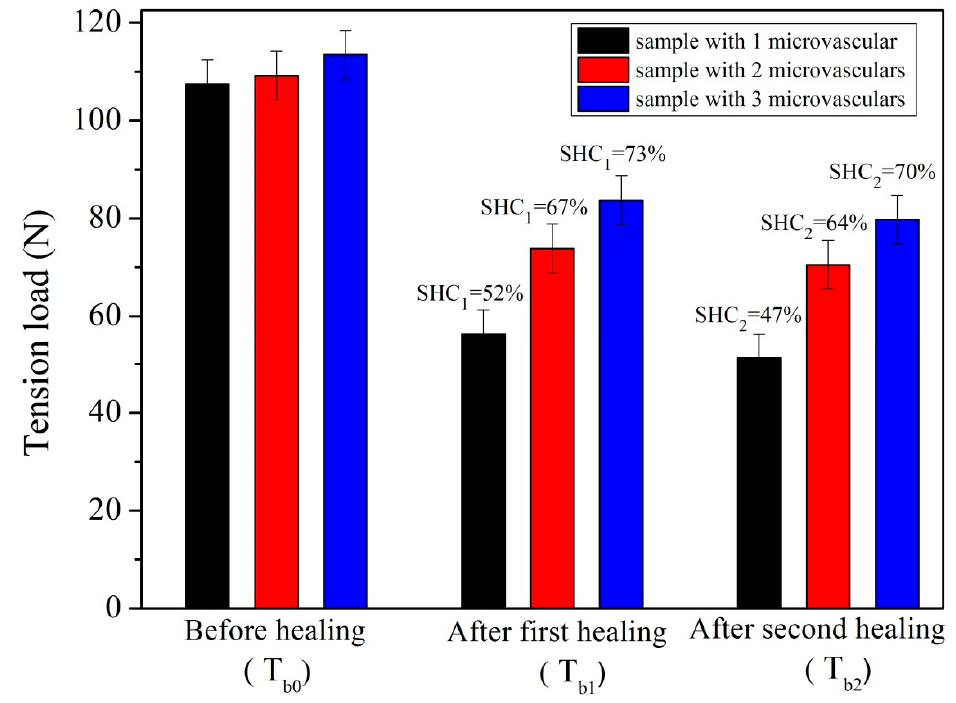
Figure 10. Tension load values and self-healing efficiency (SHC 1 and SHC 2 ) values of asphalt samples influenced by microvascular contents (1–3, paralleling to tension direction) under 0 °C during two self-healing cycles.